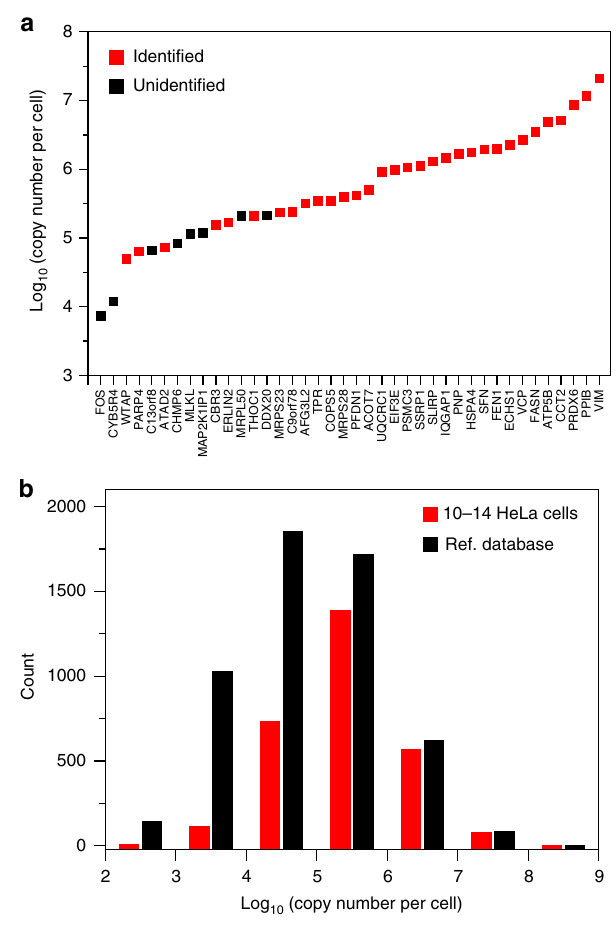
Fig. 3 Distribution of protein abundances identi fi ed from 10 to 14 HeLa cells. a Identi fi ed proteins from among the 40 proteins quanti fi ed using the PrEST-SILAC method 30 . b Comparison with the 5443 proteins quanti fi ed using the histone-based “ proteomic ruler ” method. Protein copy numbers per cell were obtained by matching them with previously reported databases